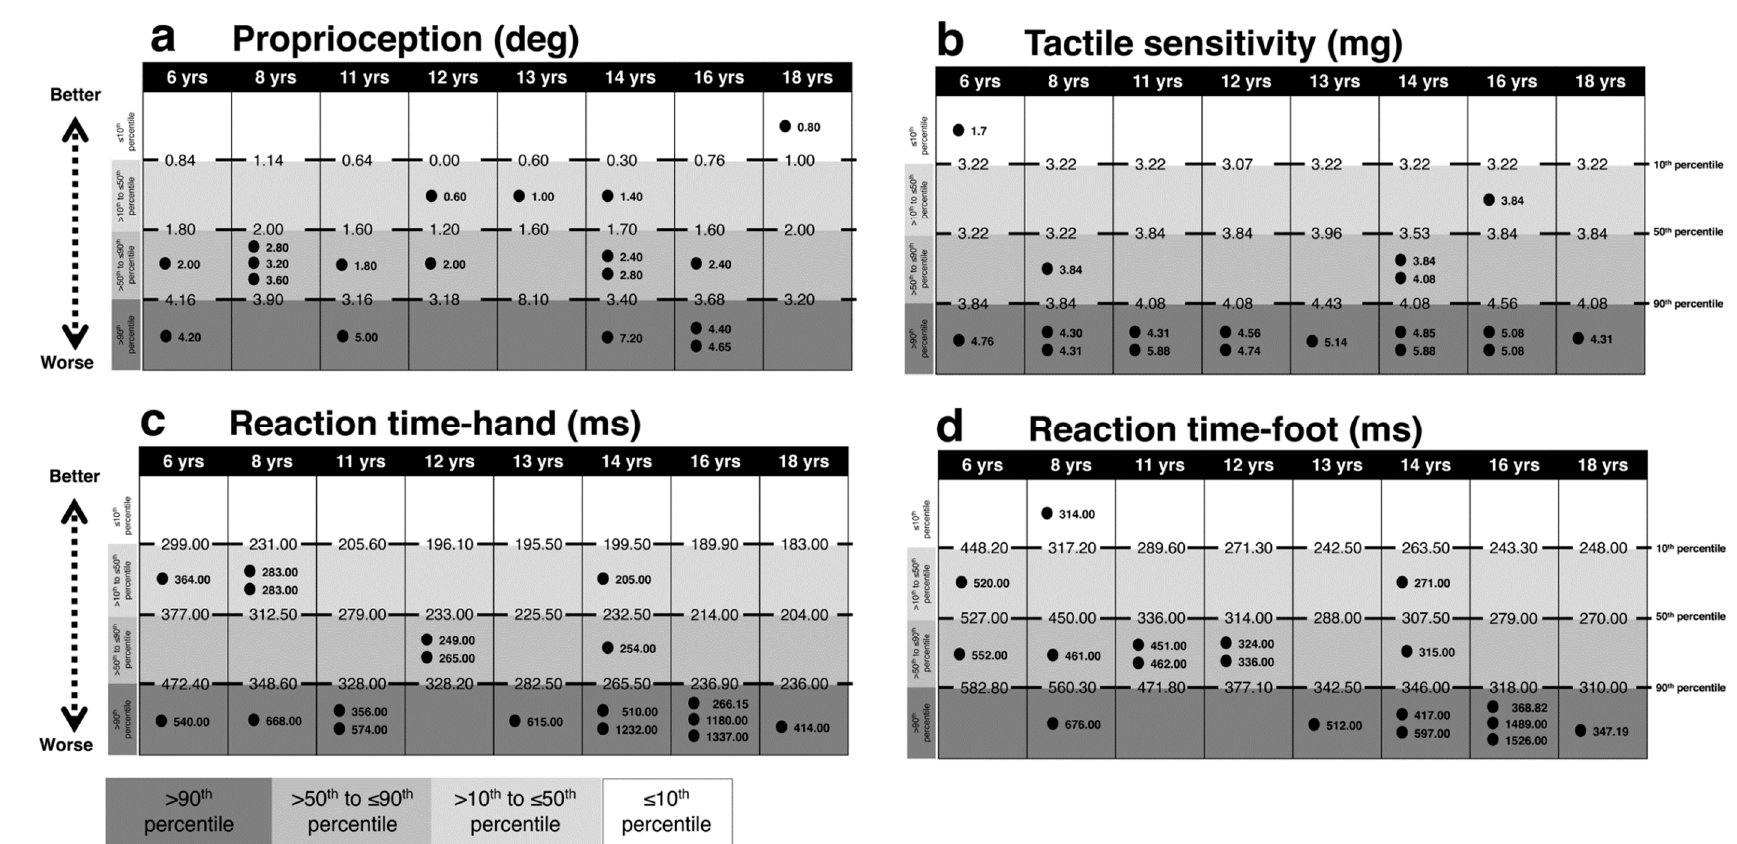
Figure 2. Comparison between each ASD subject’s performance in the PPA peripheral sensation and reaction time tests and age-matched reference values (percentiles) for TD subjects. Light gray to dark gray corresponds with better to worse performance. In ( a ) proprioception, in ( b ) tactile sensitivity, in ( c ) reaction time on hand, in ( d ) reaction time on foot. The reference value of the 10th, 50th and 90th percentiles and each ASD subject values are reported. Intervals for each performance represent: ≤ 10th, 10th < x ≤ 50th, 50th < x ≤ 90th, >90th percentile from the top to the bottom, respectively. Abbreviations: yrs, years; deg, degree; mg, milligrams; ms, milliseconds.